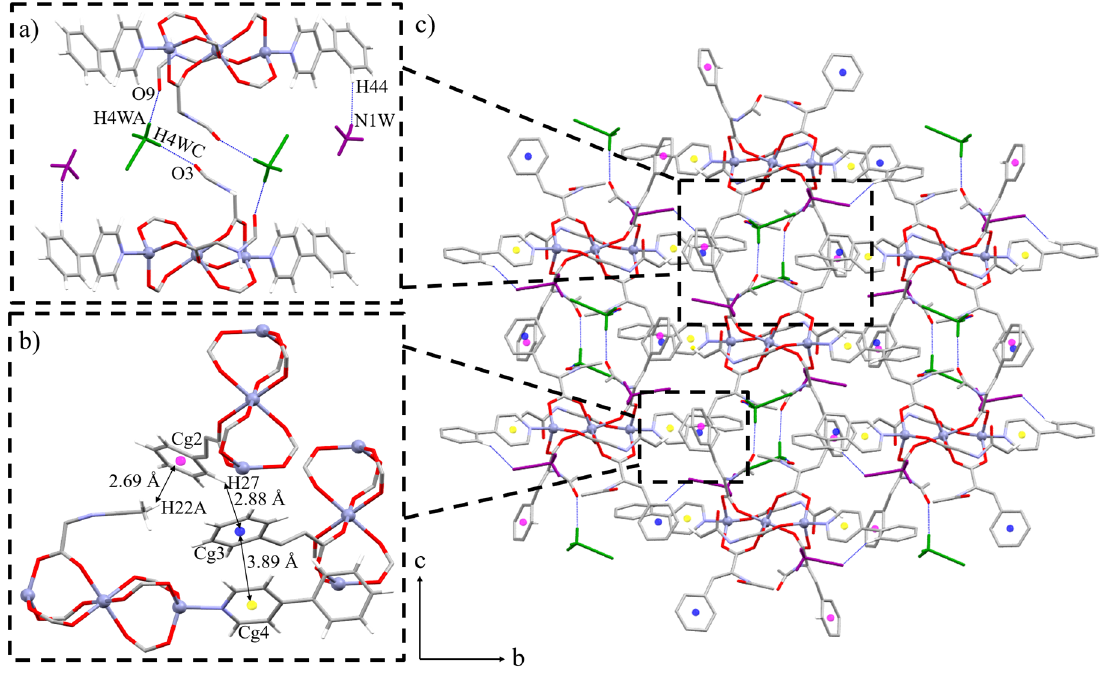
Figure 5. ( a ) In detail view of the C-H ··· N and C-H ··· O interactions of 2 · 4CH 3 CN between the two types of co-crystallized acetonitrile molecules (highlighted in green and purple) and the trinuclear units which expand the structure along the c axis. ( b ) In detail view of the C-H ··· π and π ··· π interactions which contribute to the formation of the bc plane. ( c ) General view of the resulting plane along the bc axes due to the C-H ··· O and the planar interactions. The phenyl, pyridyl, and other atoms which do not participate in any of the mentioned interactions have been omitted for clarity.